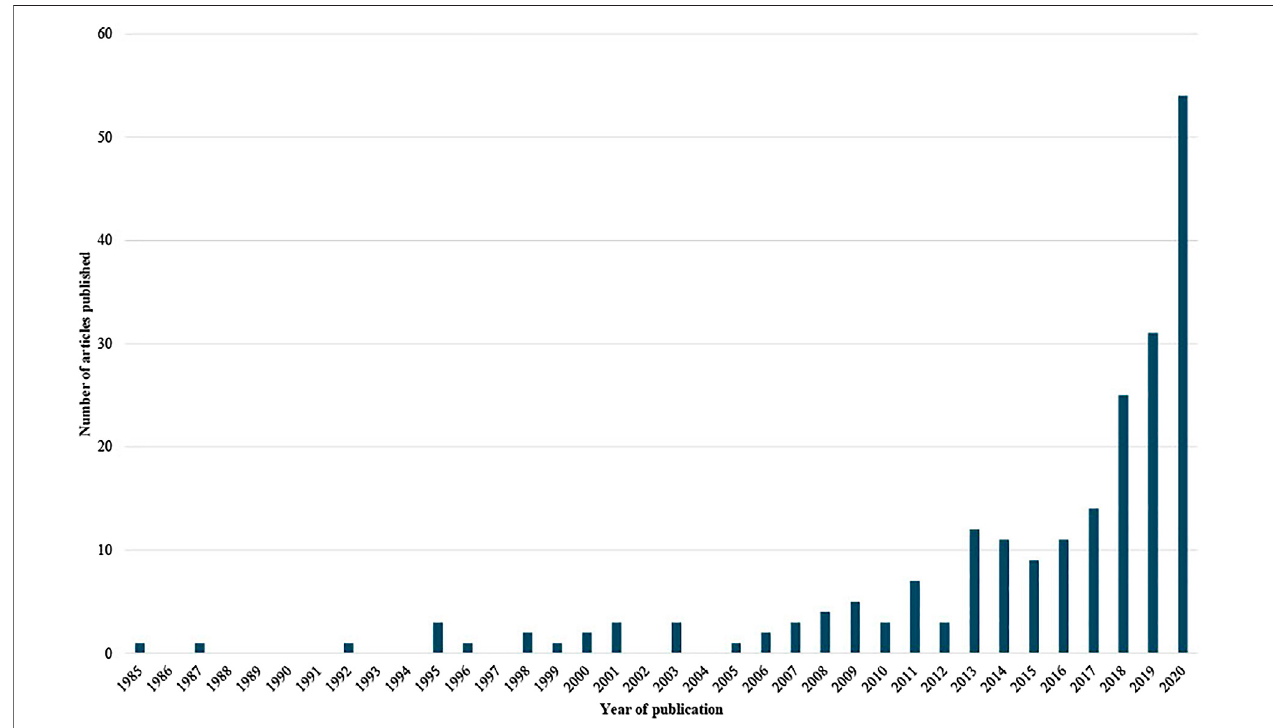
FIGURE 2 | Number of articles published each year during the 1980 – 2020 sample period ( n (cid:1) 213).